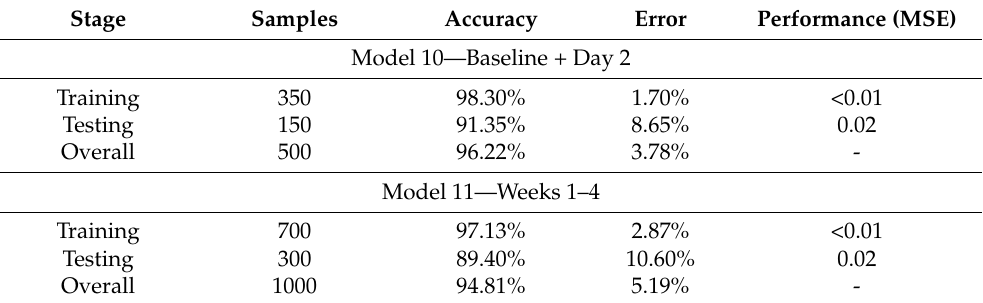
Table 4. Machine learning pattern recognition models based on artificial neural networks (Bayesian regularization) to classify soil samples into different levels of pathogen infection using the electronic nose outputs as inputs. Abbreviations: MSE: means squared error.